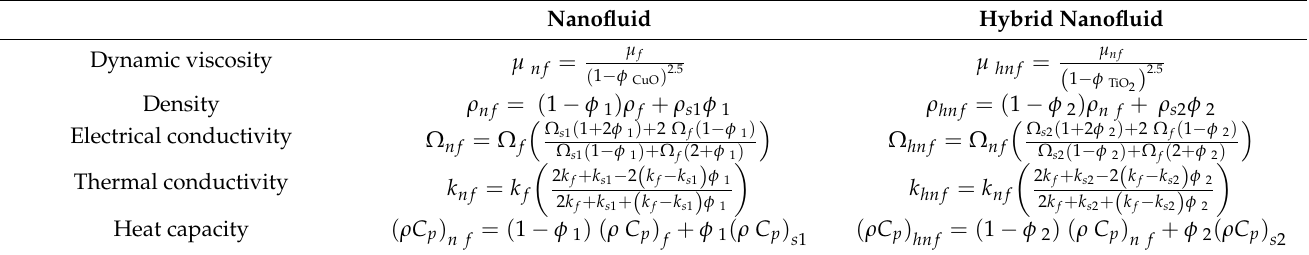
Table 1. Thermal and physical properties of the nanofluid and hybrid nanofluid.